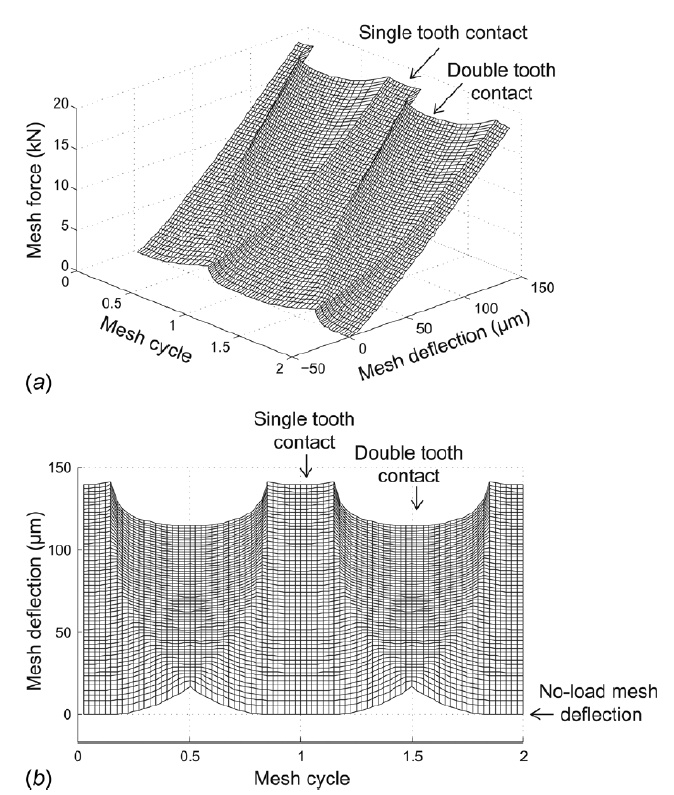
Figure 10. Force Deflection Function from [131], ( a ) 3D view, ( b ) frontal